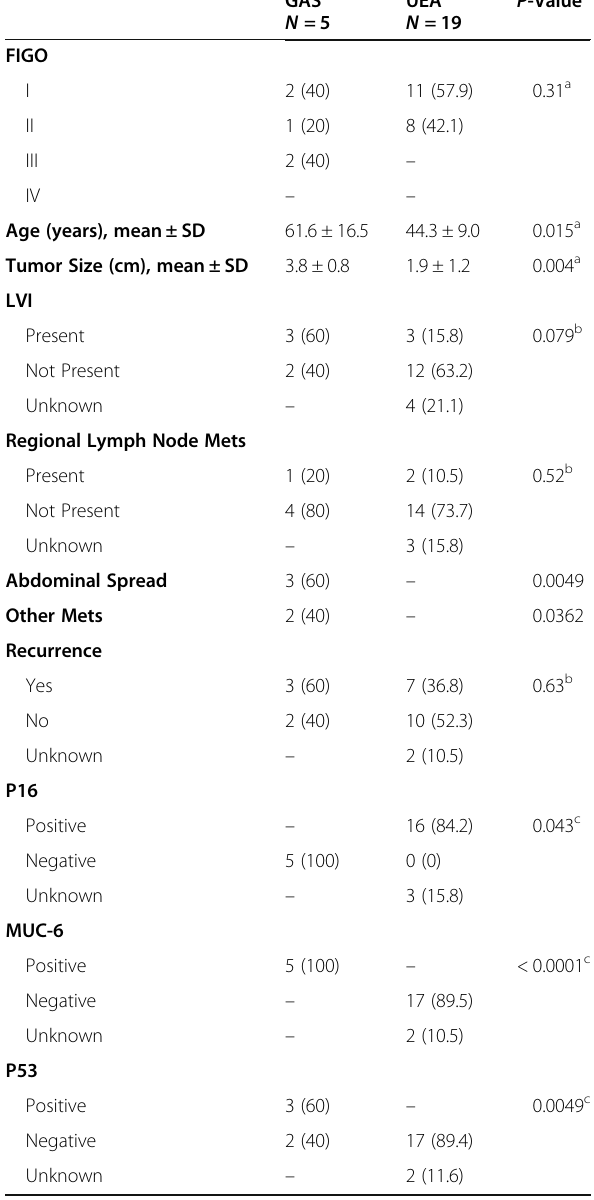
Table 2 Comparison and differences between GAS and UEA regarding stage, age, lymph-vascular permeation, lymph node status and local/distant metastases at the time of diagnosis. All data presented as count (percent), unless otherwise